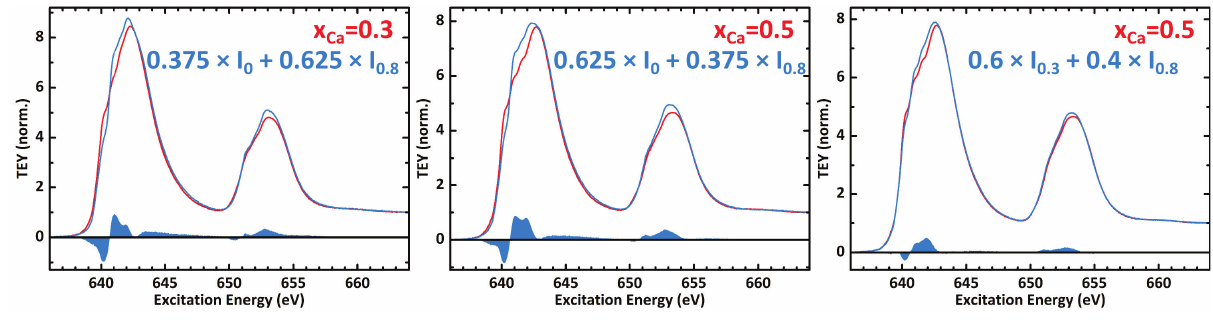
. The superpositions (blue) are assembled according to the spectra at intermediate x Ca expected nominal concentrations of the Mn 3+ and Mn 4+ species as indicated by the formulas in blue